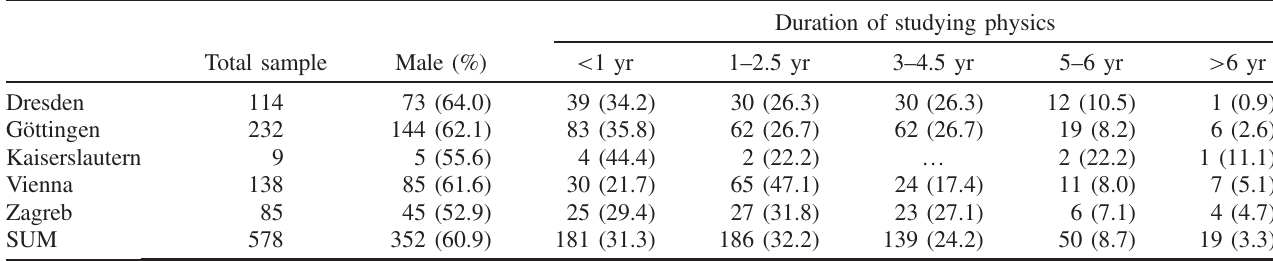
TABLE III. Information about the questionnaire sample. The number in brackets are percentages of the students belonging to different groups out of all students. All students participating in the study are divided in groups between studying less than 1 year to studying more than 6